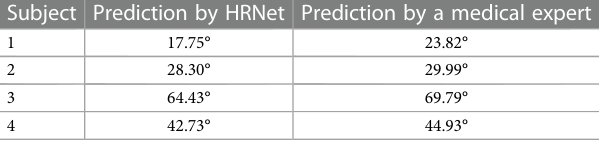
TABLE 5 Comparison between human expert vs. AI for penile angle prediction. Subject Prediction by HRNet Prediction by a medical